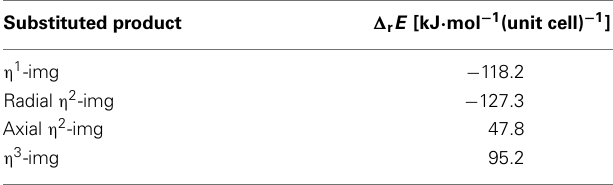
Table 1 | Reaction energies for the condensation of CH 3 Si(OCH 3 ) 3 with the inner surface silanols leading to different products .